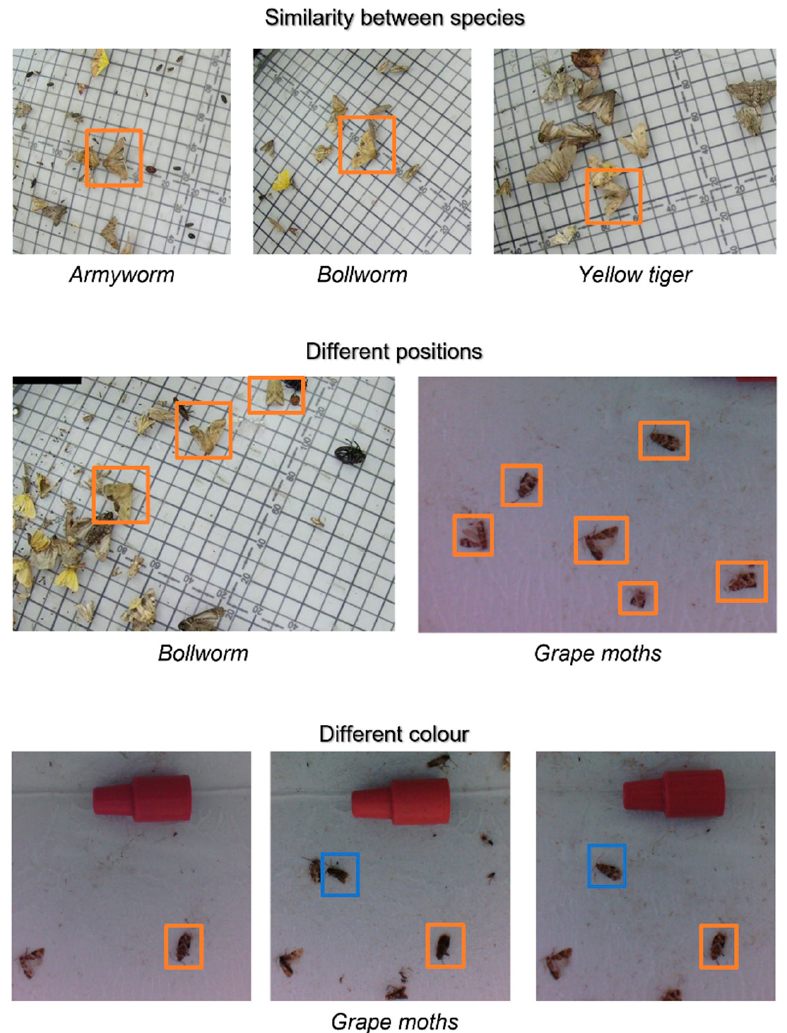
Figure 5. Examples of similarity between species, different positions of the same insect, and the different colours of the same insect. Images from the dataset Pest24 adopted from [24] and provided by